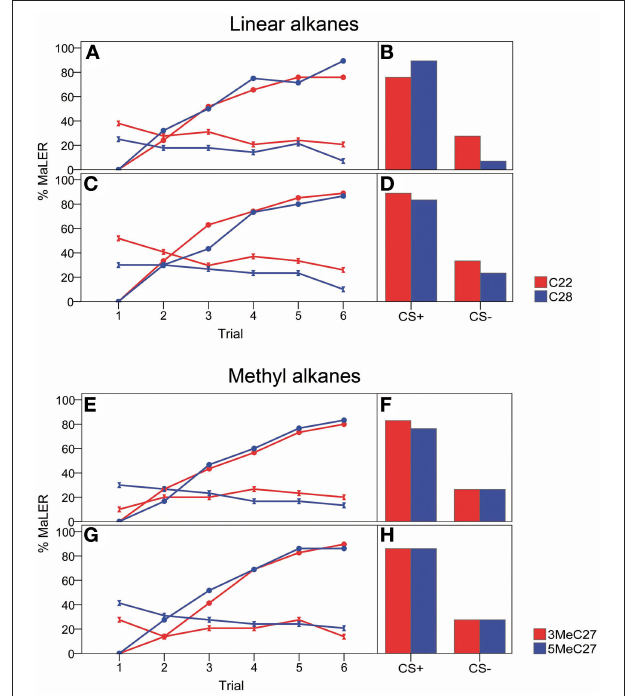
FIGURE 1 | Wide range: acquisition curves and retention tests for linear (C 22 , C 28 ) and methyl alkanes (3-MeC 27 and 5-MeC 27 ) showing the response probability to the wide concentration range expressed as the proportion of ants extending their maxilla-labium (MaLER). In the acquisition curves (A,C,E,G) , responses to the conditioned stimulus are shown by circles (CS + ) or double triangles (CS − ). Retention tests show the proportion of ants responding to both CS + and CS − , 1h after training. (A,B,E,F) low concentration rewarded, high concentration punished (low + /high − vs. high + /low − ). (C,D,G,H) high concentration rewarded, low concentration punished (high + /low − vs. low +